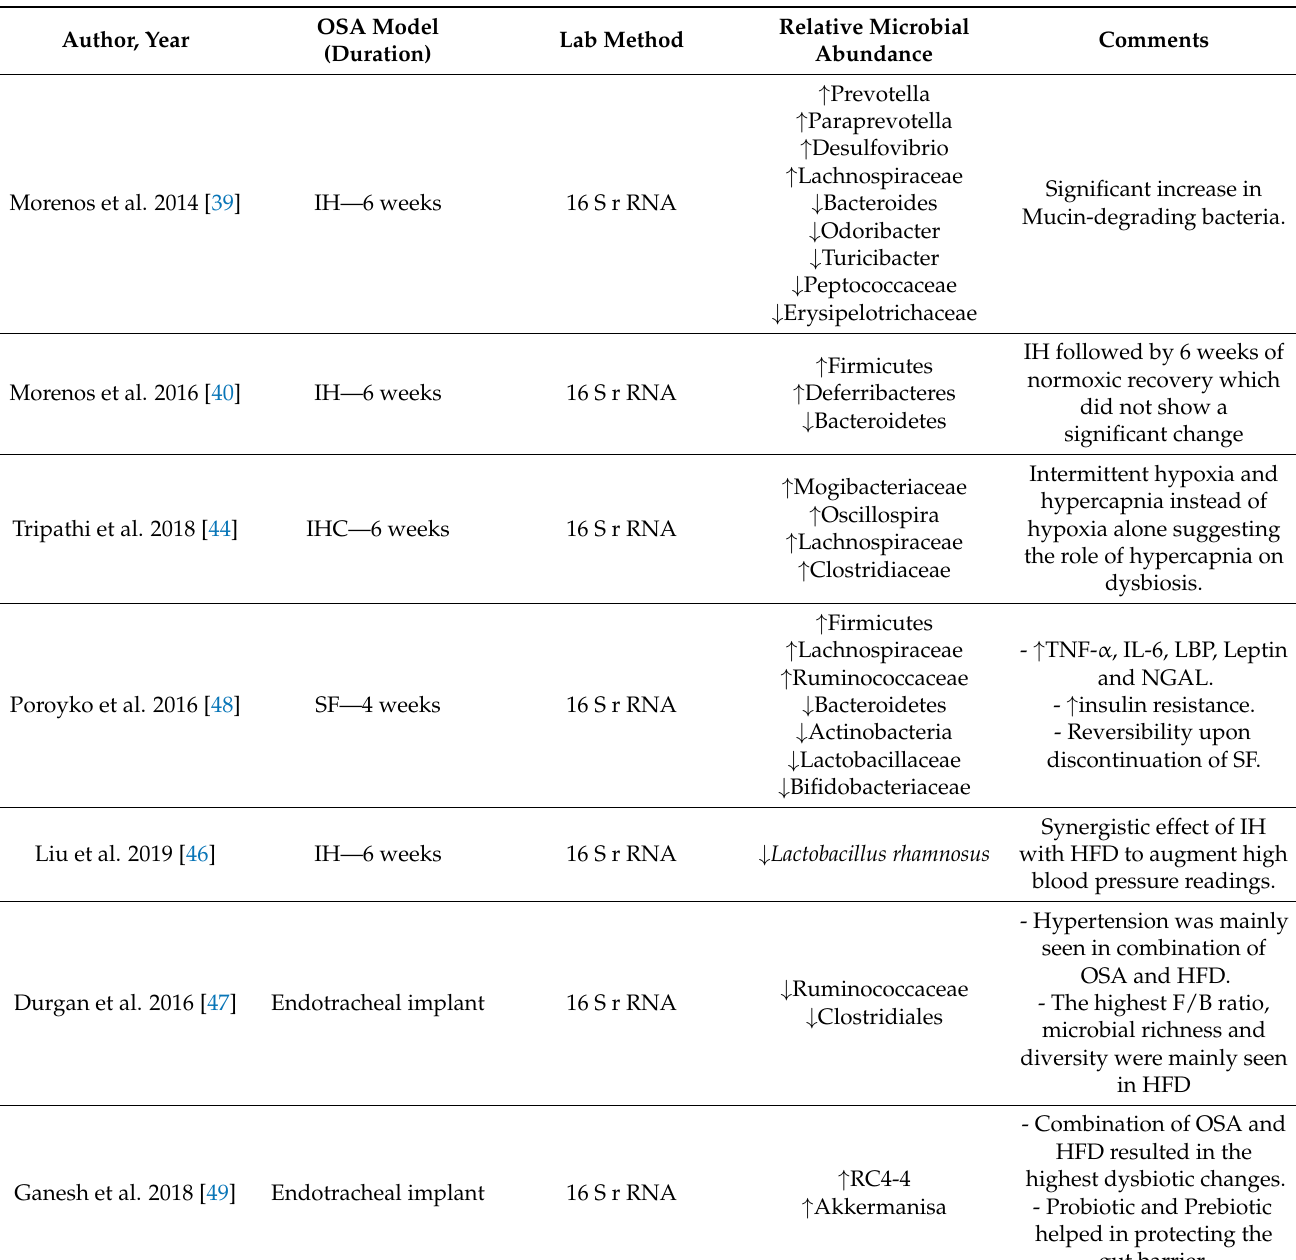
Table 2. OSA and gut dysbiosis in animal